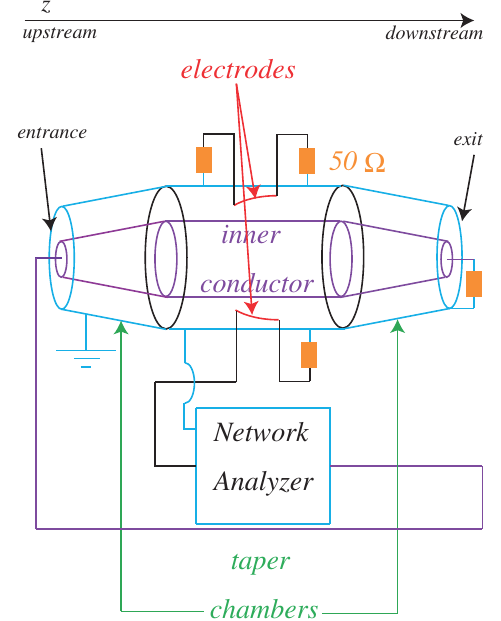
FIG. 19. A schematic of the measurement setup.